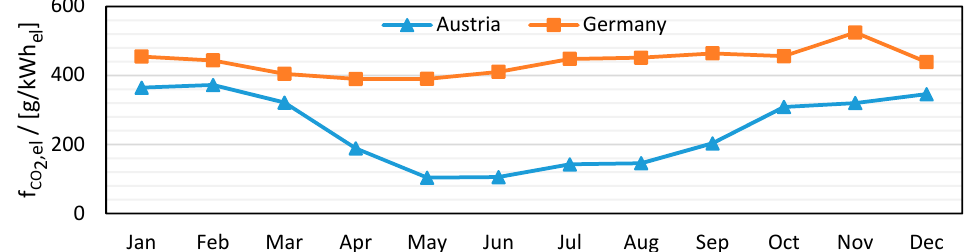
Figure 4. Monthly CO 2 conversion factors for the electricity network of Germany and Austria derived from measured data from 2019 [31,32].